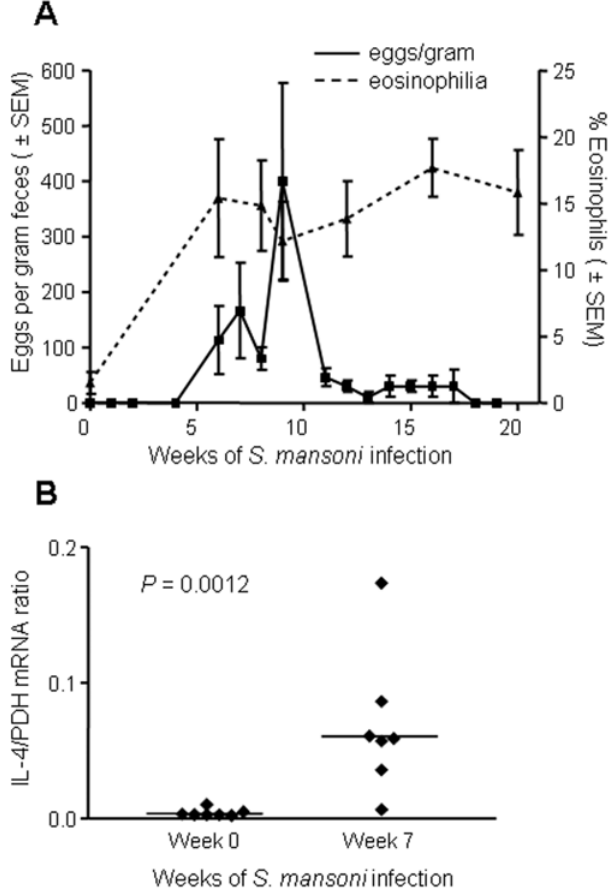
Figure 1. Parasitologic and immunologic changes in rhesus macaques infected with Schistosomamansoni . (A) Eggs per gram feces in stool samples and percent eosinophils in blood from monkeys that were infected with S. mansoni ; (B) IL-4 mRNA expression in PBMC of all S. mansoni -positive rhesus monkeys prior to exposure to SHIV-C. The ratios of IL-4 mRNA copies to mRNA copies of the housekeeping gene PDH are shown. Lines represent group medians. Statistical analysis of data in panel B was performed using the Wilcoxon rank-sum